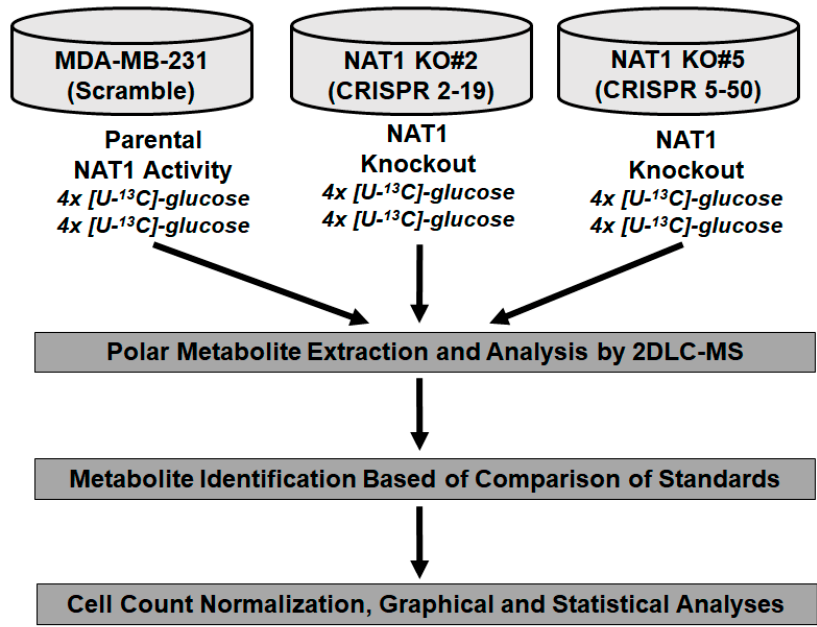
Figure 1. Schematic of Experimental Approach. Four biological replicates from each cell line were collected for both [U- 13 C]- and [U- 12 C]-glucose. Samples were analyzed by 2DLC-MS/MS. Following metabolite identification, data was normalized to cell counts and analyzed for consistent statistical differences between NAT1 KO and MDA-MB-231 (scramble) cells.